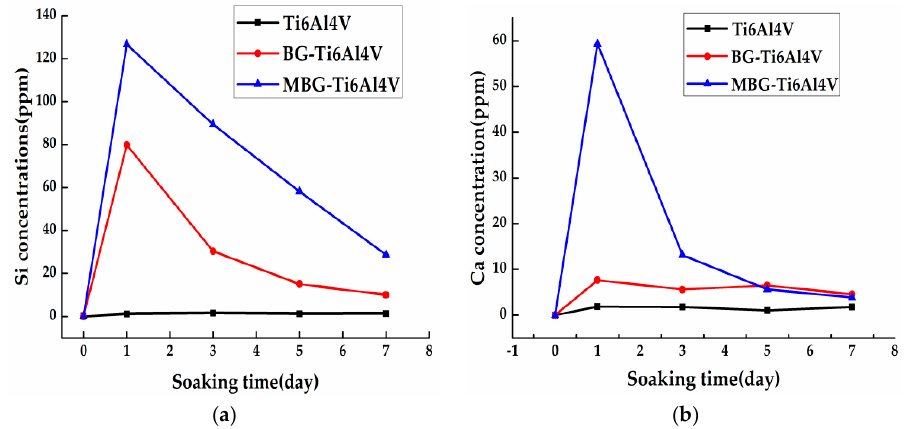
Figure 6. Ion concentrations of ( a ) Si and ( b ) Ca in the Tris-HCl solution after soaking of the scaffolds for one, three, five, and seven days.